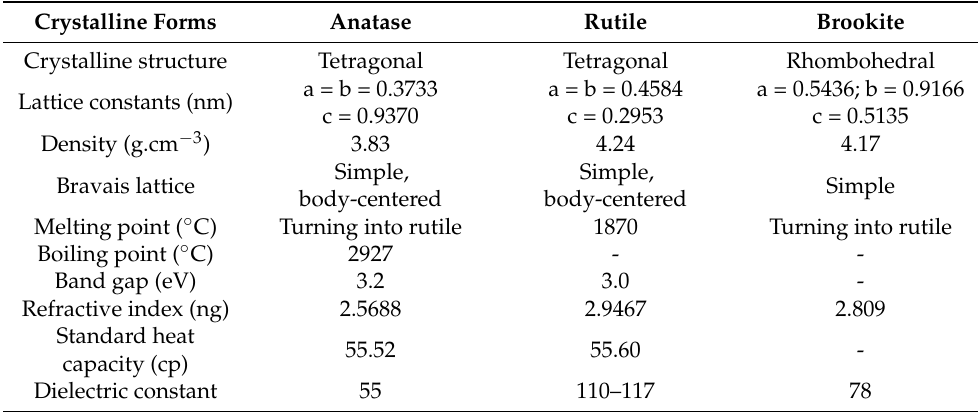
Table 2. Chemo-physical properties of TiO 2 (adapted from